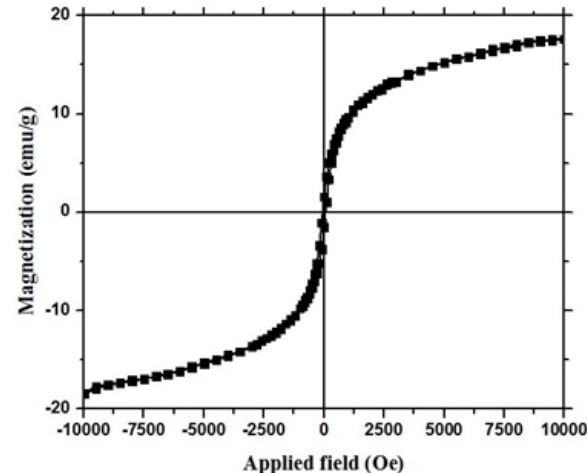
O nanocomposite. 2 4